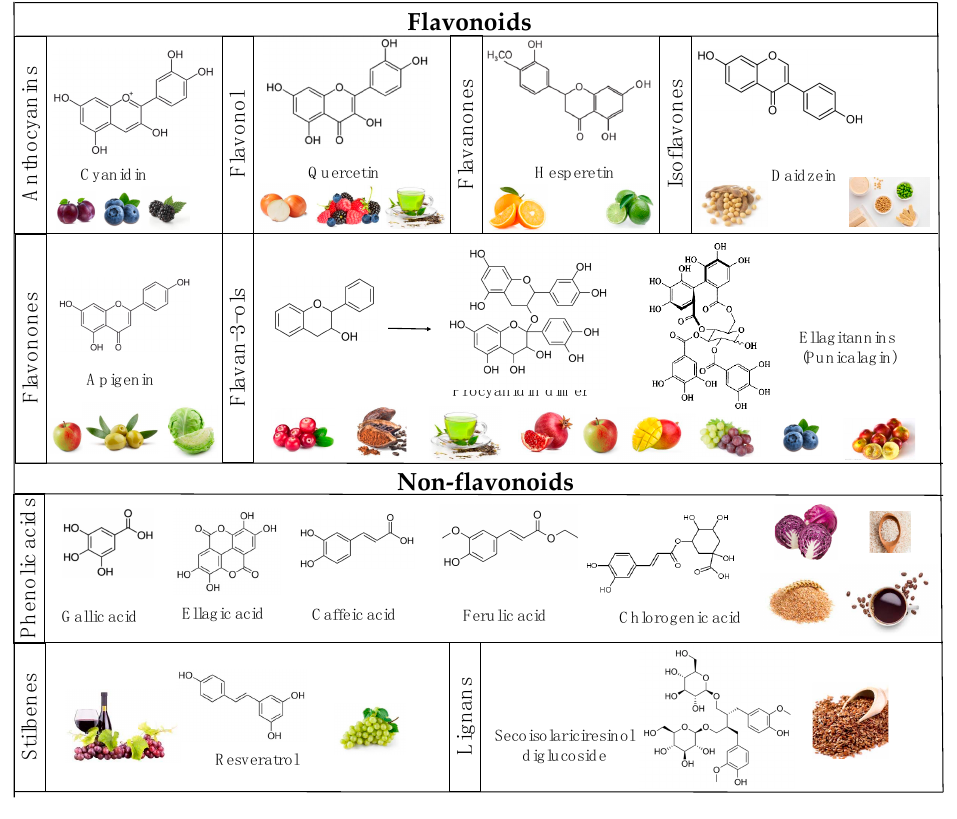
Figure 2. Chemical structures of polyphenol classes of flavonoids and non-flavonoids and their main food sources.